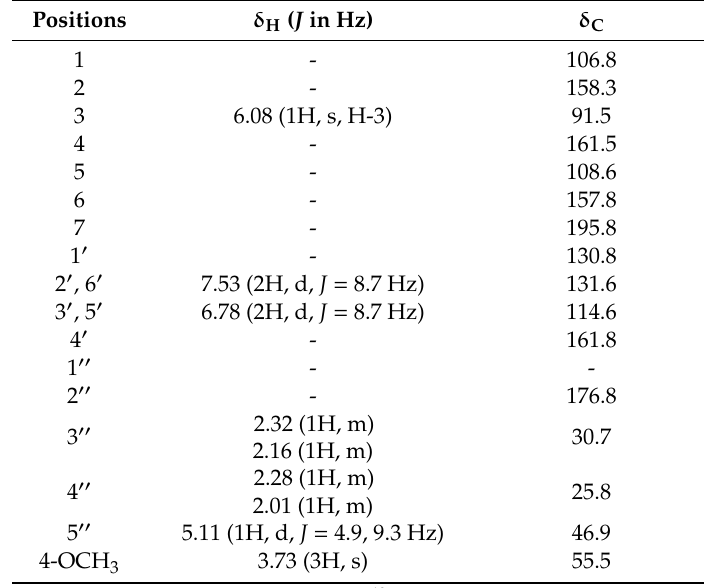
Table 1. 1 H NMR and 13 C NMR spectroscopic data for compound 1 (DMSO- d 6 ).